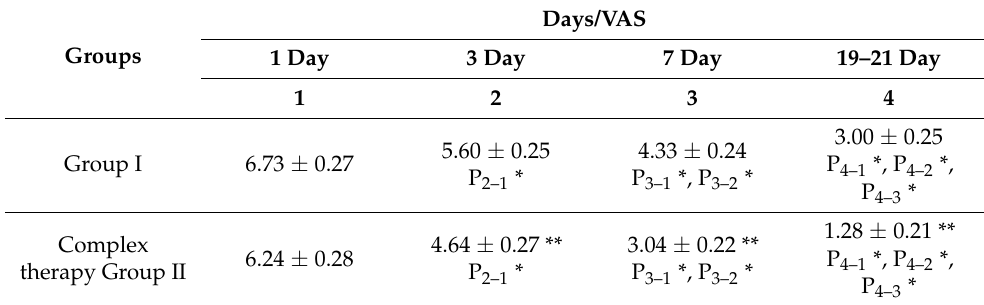
Table 1. Dynamics of BNS assessment by VAS (M ± m).